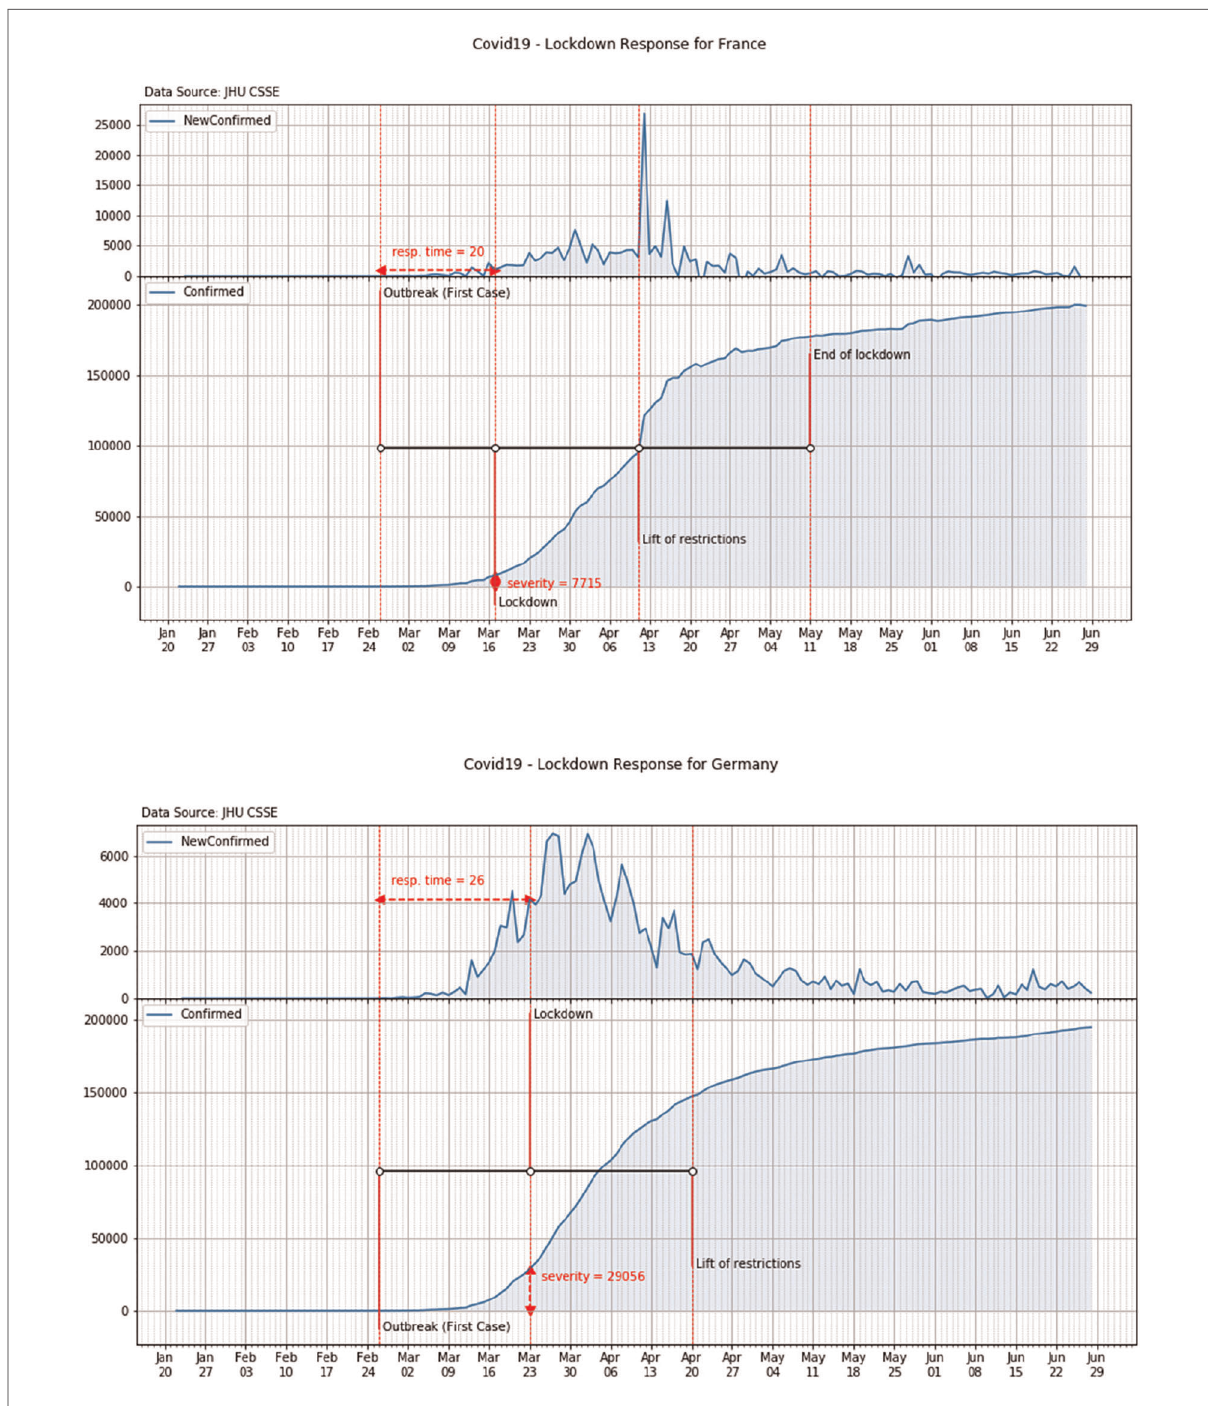
FIGURE 5 Response time and severity of the lockdown in France (top panel) and Germany (bottom